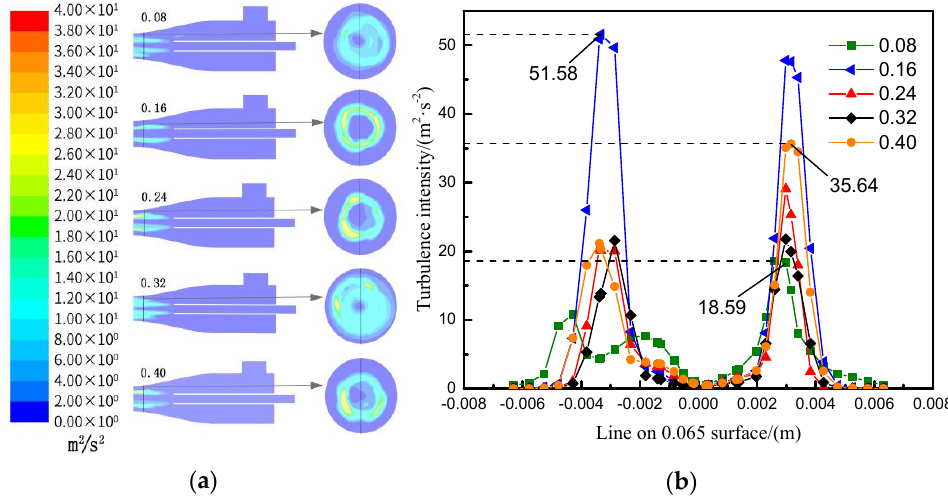
Figure 8. Distribution diagram of turbulence intensity with different gas–liquid ratios. ( a ) Distribution of turbulence intensity in the annular jet nozzle on plane Y = 0. ( b ) Distribution curves of the values of turbulence intensity at the intersection between plane Y = 0 and cross–section X = 0.065 m.